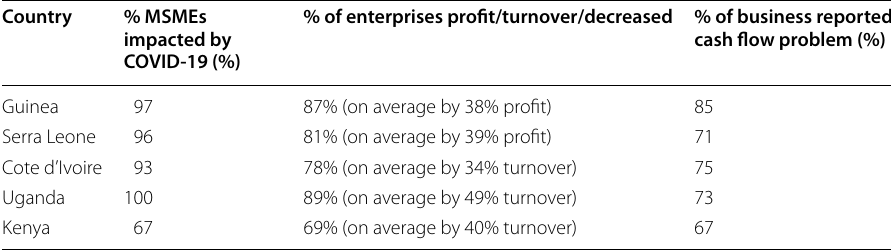
Table 1 Impact of COVID-19 on MSMEs financial performance